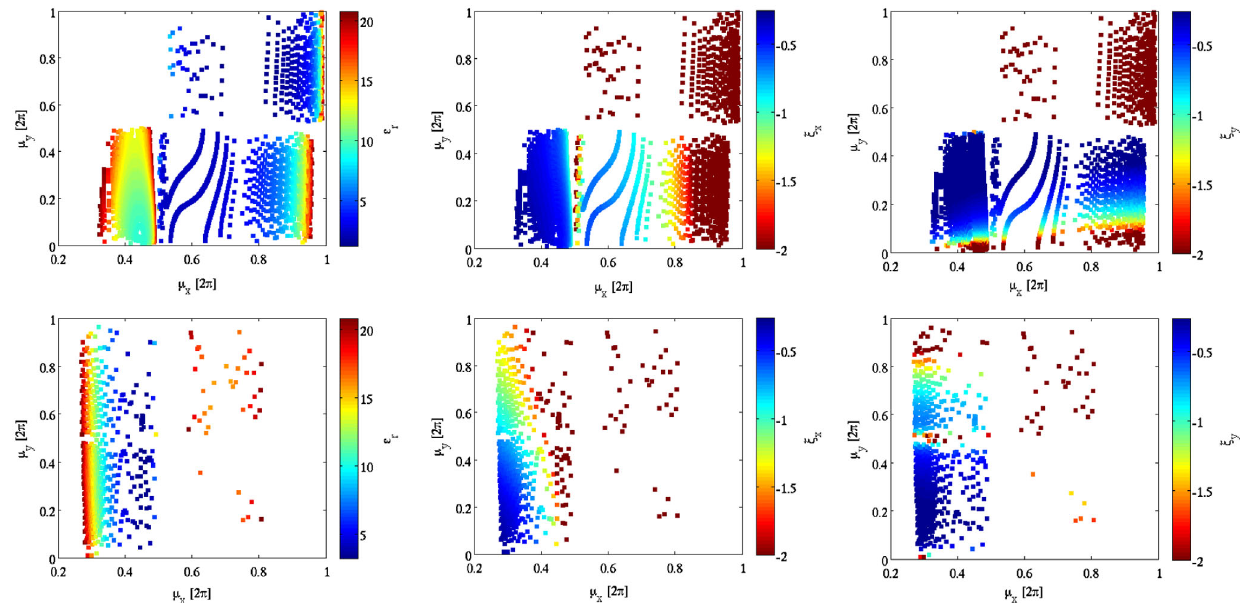
FIG. 6. Parametrization of the cell detuning factor ϵ (left), and the horizontal (middle) and vertical (right) chromaticities with the r horizontal and vertical phase advances of the cell is presented for each case, for a conventional (top) and a modified (bottom) TME cell.